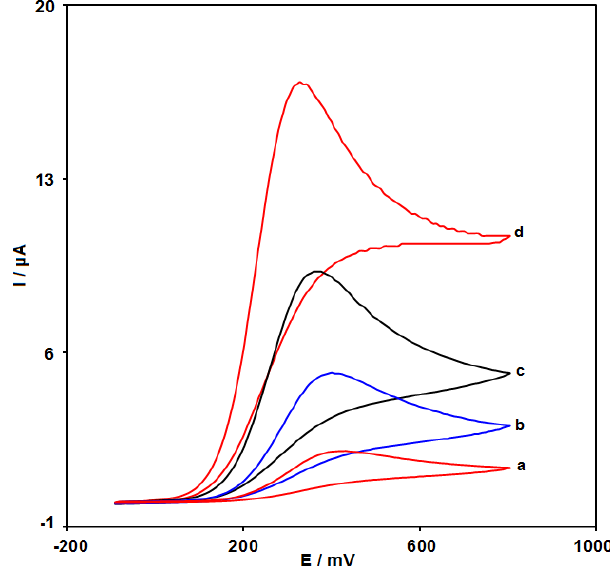
Figure 7. CVs at the unmodified SPE (curve a), the ZIF-67/SPE (curve b), the GO/SPE (curve c), and the GO/ZIF-67/SPE (curve d) in 0.1 M PBS at pH of 7.0 in the presence of 200 μ M epinine at a 50 mVs − 1 scan rate.